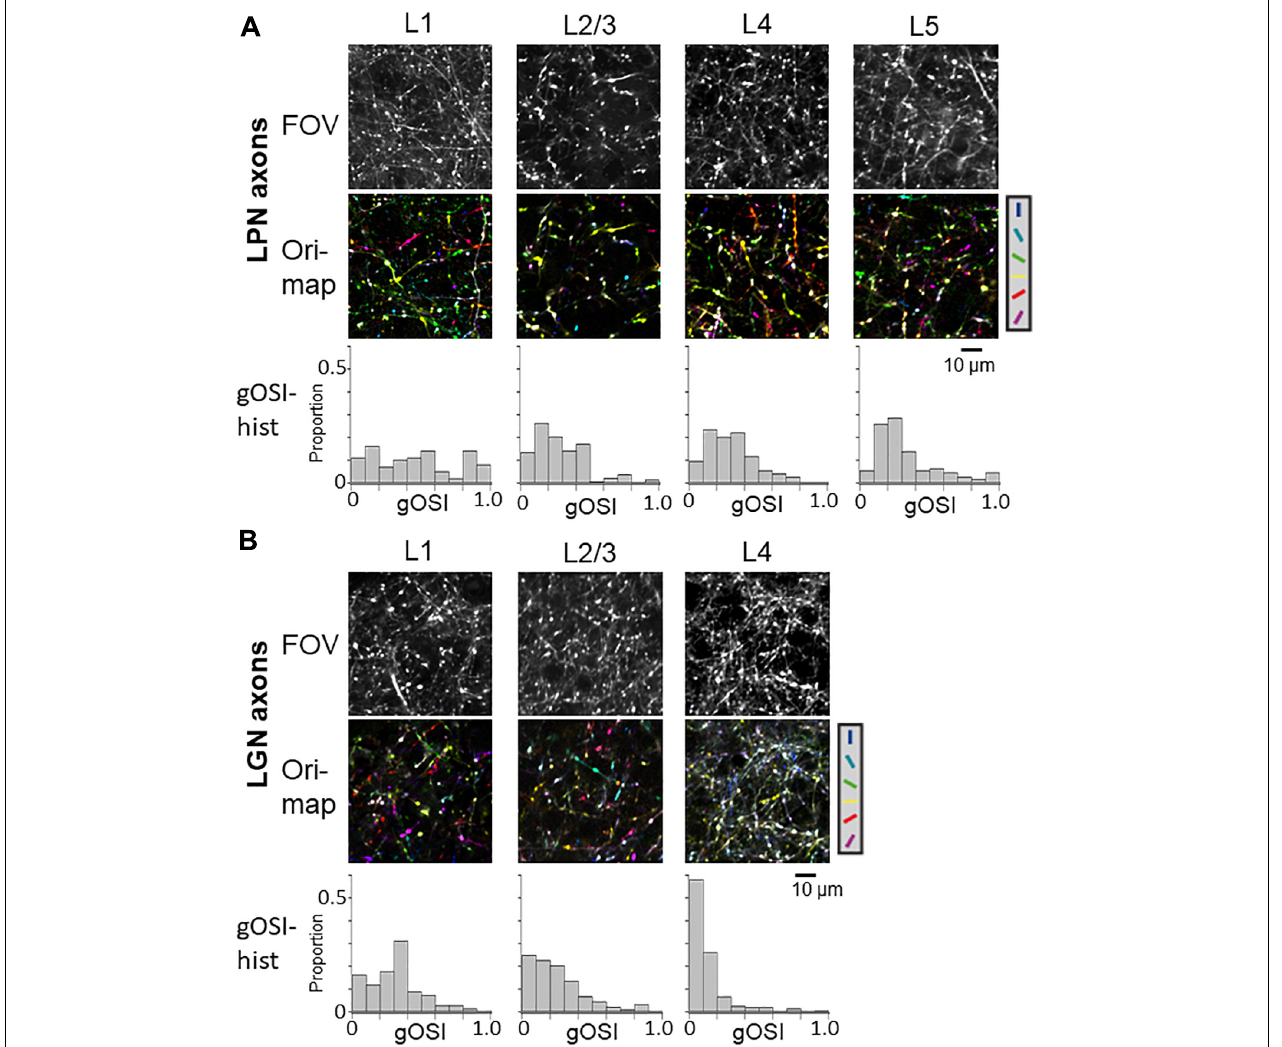
FIGURE 3 | Orientation selectivity of LPN and LGN boutons in V1. (A) FOV images (upper), orientation color map (middle) and distribution of gOSI (lower) of the LPN axons in V1. (B) FOV images (upper) and orientation color map (middle) and distribution of gOSI (lower) of the LGN axons in V1. Only the LGN axons in the layer 4 indicated low orientation selectivity. LPN, lateral posterior nucleus; LGN, lateral geniculate nucleus; V1, primary visual cortex; FOV, field-of-view. * P ≤ 0.05, *** P ≤ 0.001 The data of LGN axons are re-use from the previous publication (Kondo and Ohki,